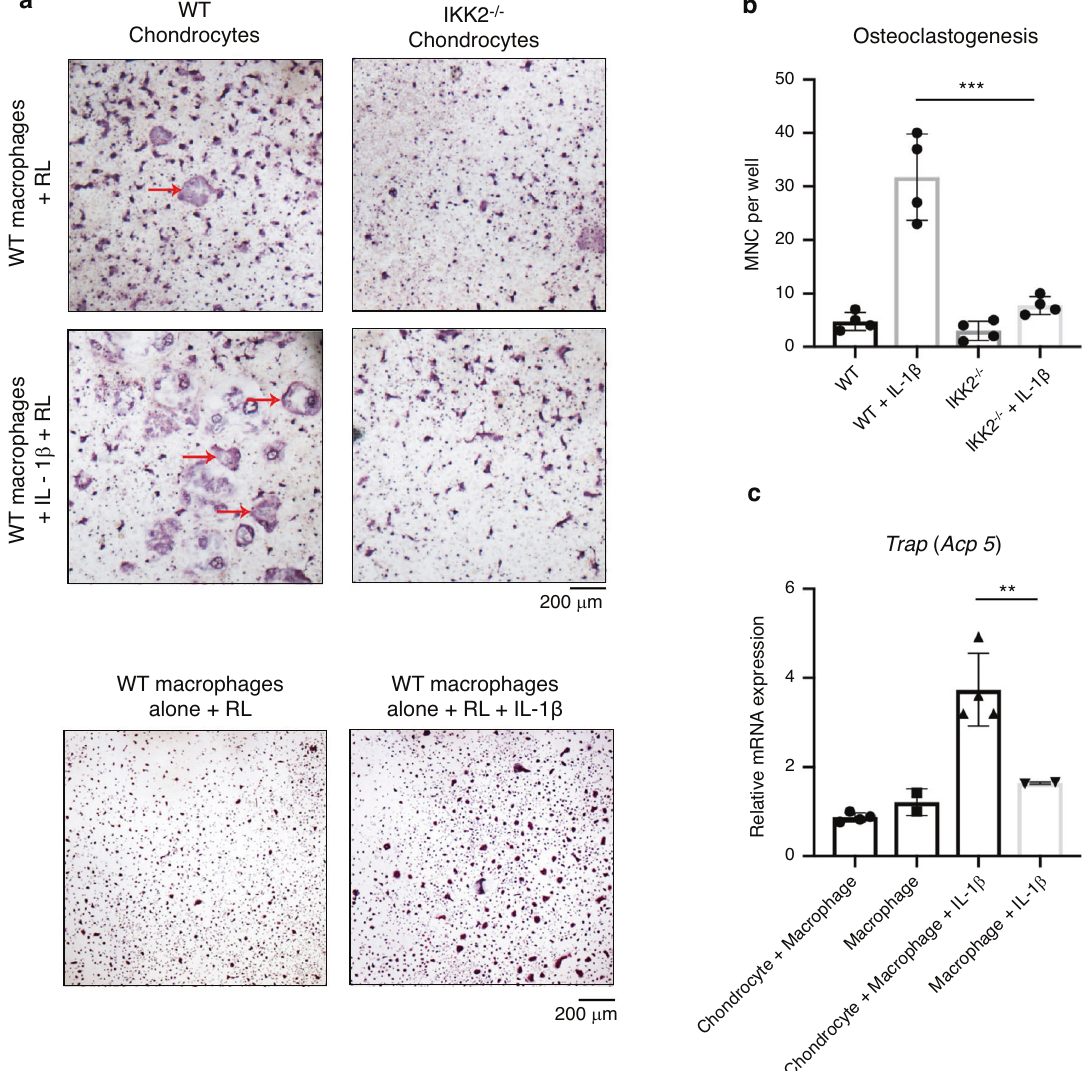
Fig. 2 Chondrocytes support osteoclastogenesis under in fl ammatory conditions. a Primary IKK2 f/f chondrocytes were isolated and infected with adenoviral-GFP or adenoviral-cre to delete IKK2. Bone marrow macrophages were then added to the culture. Permissive levels of Rankl (5 ng·mL − 1 ) was added ± IL-1 β (10 ng·mL − 1 ) for 3 days. Cultures were fi xed and stained for TRAP positive osteoclasts (red arrows). Macrophages alone cultures are displayed as control. b Number of large, multi nucleated cells (MNC) in macrophage-chondrocyte co-culture were quanti fi ed by counting. (WT + IL-1 β vs IKK2 − / − + IL-1 β *** P = 0.000 2, n = 4 wells from representative experiment). Bars represent mean ± S.D. c mRNA was isolated from co-cultures of chondrocytes and macrophages ± IL-1 β . Gene expression analysis was performed for TRAP (** P = 0.001 7, n = 4). Bars represent mean ±